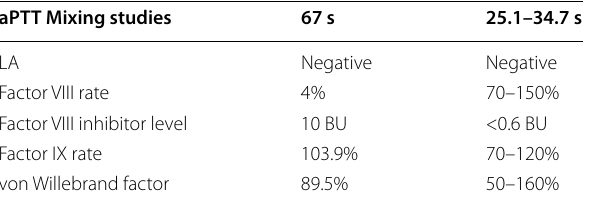
Table 3 Immunosuppressive therapy for AHA FVIII 1% and < 20 BU/ml Steroids alone ≥ FVIII < 1% or > 20 BU/ml Steroids and cyclophosphamide or rituximab 3–4